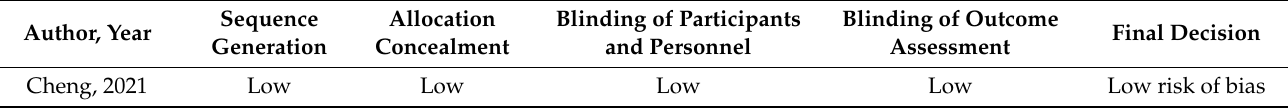
Table 3. Cochrane bias assessment for